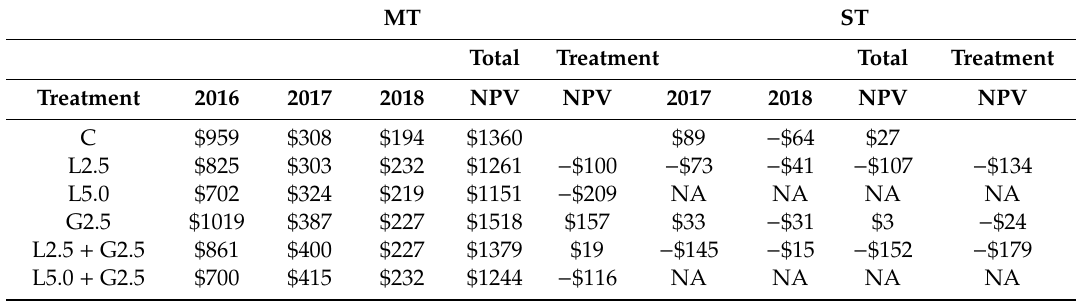
NA indicates treatment not applied. Table 5. The LT experiment wheat grain yields (t ha − 1 ) observed for the 7 sampling years, between 2008-2016. The total represents the sum of the grain yields over the study period. Treatments were applied twice, in March of 2008 and 2013. Treatments were defined as the total amount of L or G used, and included control (C), 2 t L ha − 1 (L2), 4 t L ha − 1 (L4), 8 t L ha − 1 (L8), 2 t G ha − 1 (G2) and 2 t L ha − 1 plus 1 t G ha − 1 (L4 + G2). For each year, di ff erent lower case letters indicate a significant di ff erence between means at p ≤ 0.05. LSD values are presented at p ≤